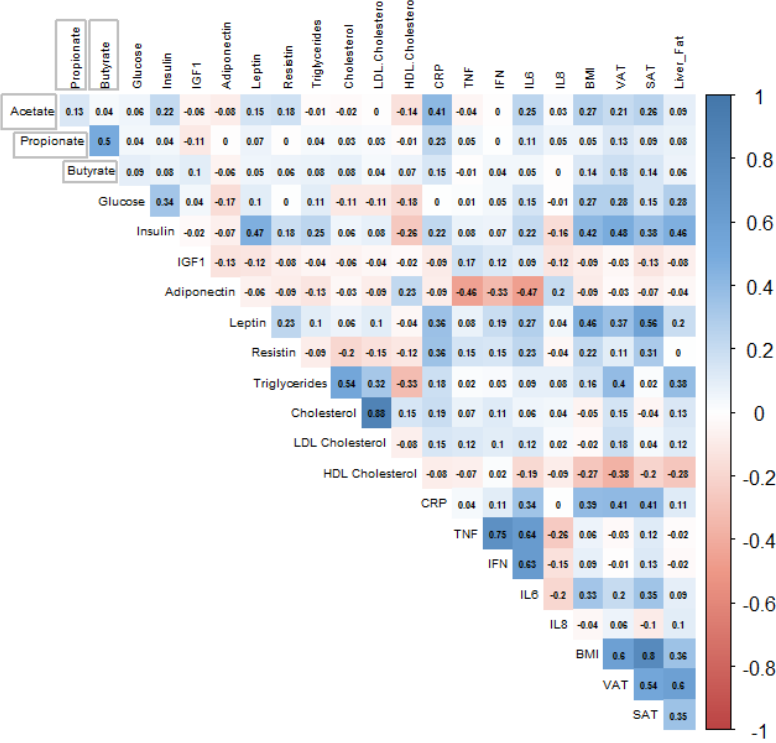
Figure 2. Spearman’s correlation of acetate, propionate, and butyrate with selected routine biomarkers, body composition and percentage liver fat, n = 132.